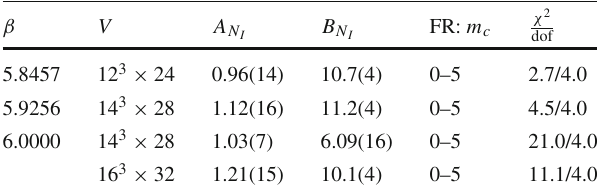
, B N , and χ 2 / dof obtained by fitting I I m c + B N to the results of N I I